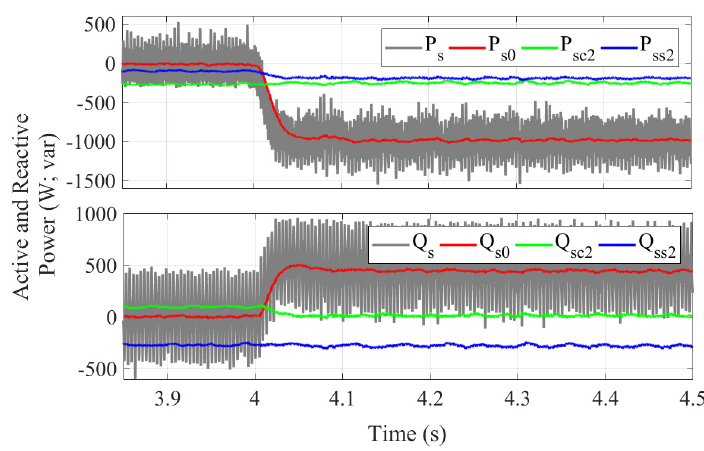
Figure 10. Stator active (W) and reactive (var) power at the beginning of the activation of Objective I for experimental tests.